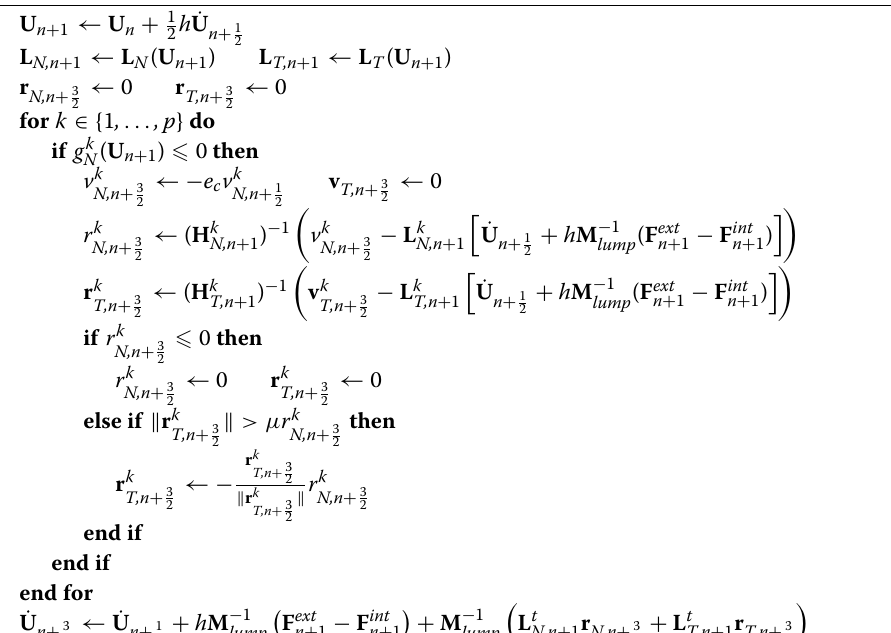
Algorithm 2 CD-Lagrange—frictional